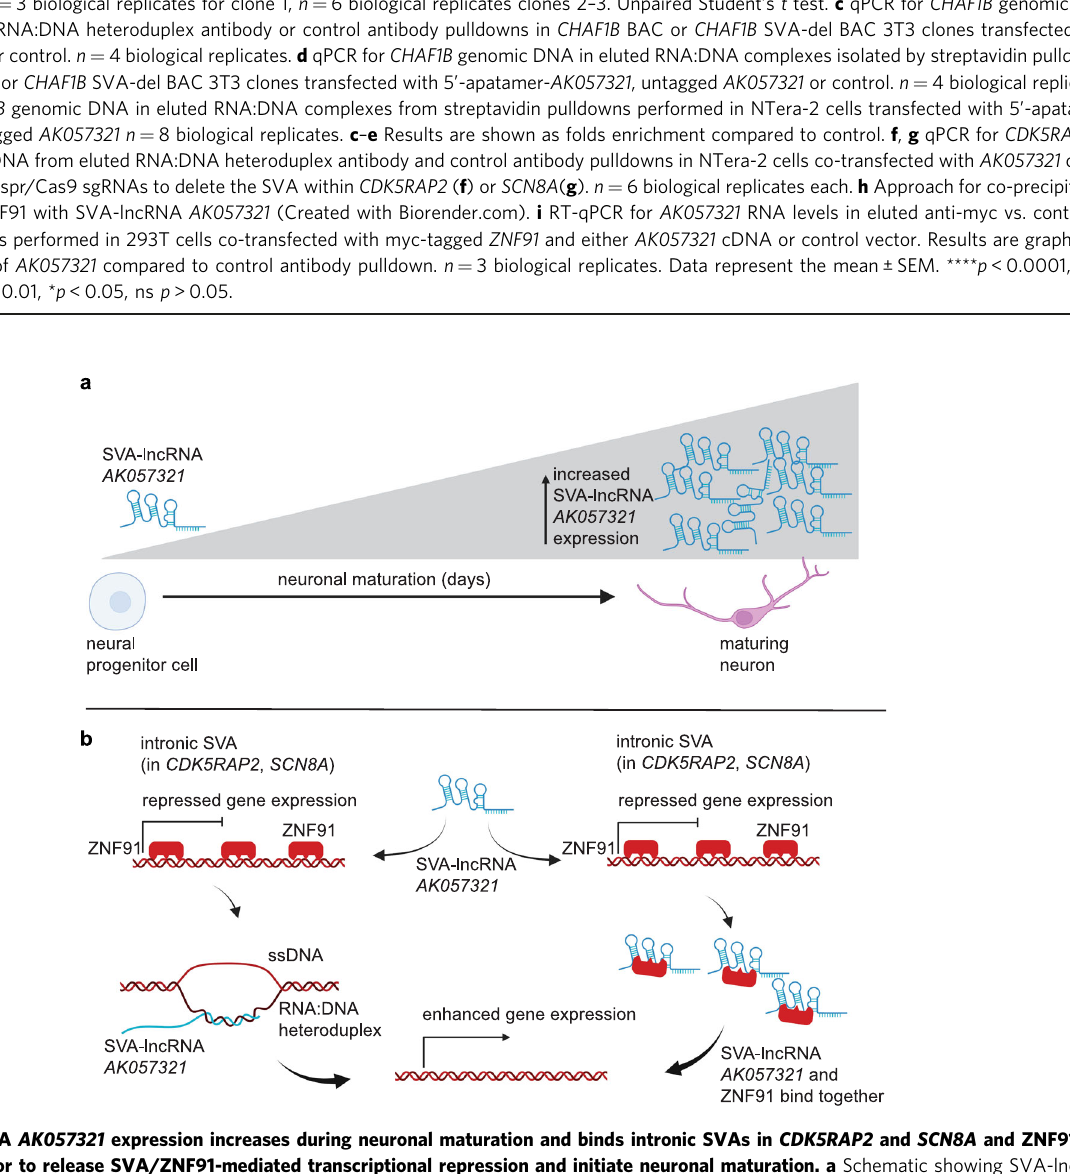
Fig. 8 SVA-lncRNA AK057321 expression increases during neuronal maturation and binds intronic SVAs in CDK5RAP2 and SCN8A and ZNF91 transcription factor to release SVA/ZNF91-mediated transcriptional repression and initiate neuronal maturation. a Schematic showing SVA-lncRNA AK05732 increases as neural progenitor cells mature into glutamatergic neurons. b Schematic where SVA-lncRNA AK05732 forms an RNA:DNA heteroduplex with intronic SVAs in CDK5RAP2 and SCN8A and binds to the ZNF91 transcription factor that otherwise represses expression of genes containing an intronic SVA (Created with antibody co-precipitated CDK5RAP2 (Fig. 7f) and SCN8A (Fig. 7g) genomic sequences. Notably, Cas9-gRNA deletion of the SVA sequences decreases the recovery of CDK5RAP2 and SCN8A genomic sequence (Fig. 7f, g). The results suggest SVA- lncRNA AK057321 may form RNA:DNA heteroduplexes with intronic SVAs in the CDK5RAP2 and SCN8A genes (see diagram in Fig. 8). The presence of an entire SVA sequence in SVA-lncRNA AK057321 (Fig. 1b; exon 3) suggested the possibility that ZNF91 protein, that binds SVA deoxyribonucleic acid sequences in the genome, might also bind SVA ribonucleic acid sequences in SVA- lncRNA AK057321 . Myc-tagged ZNF91 protein was co-expressed